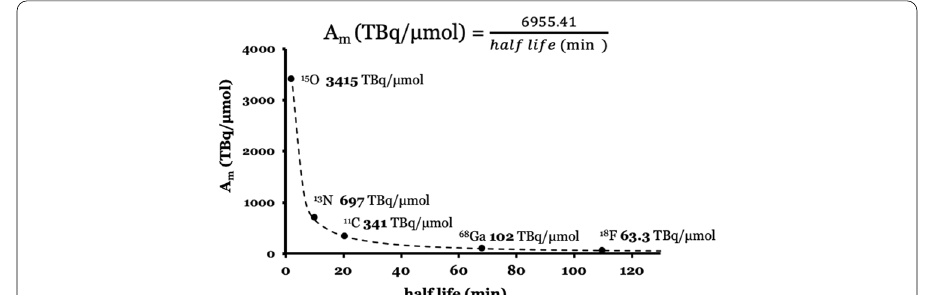
Fig. 1 The maximum theoretical molar activity measured in TBq/µmol for PET radionuclides 15 O, 13 N, 11 C, 68 Ga and 18